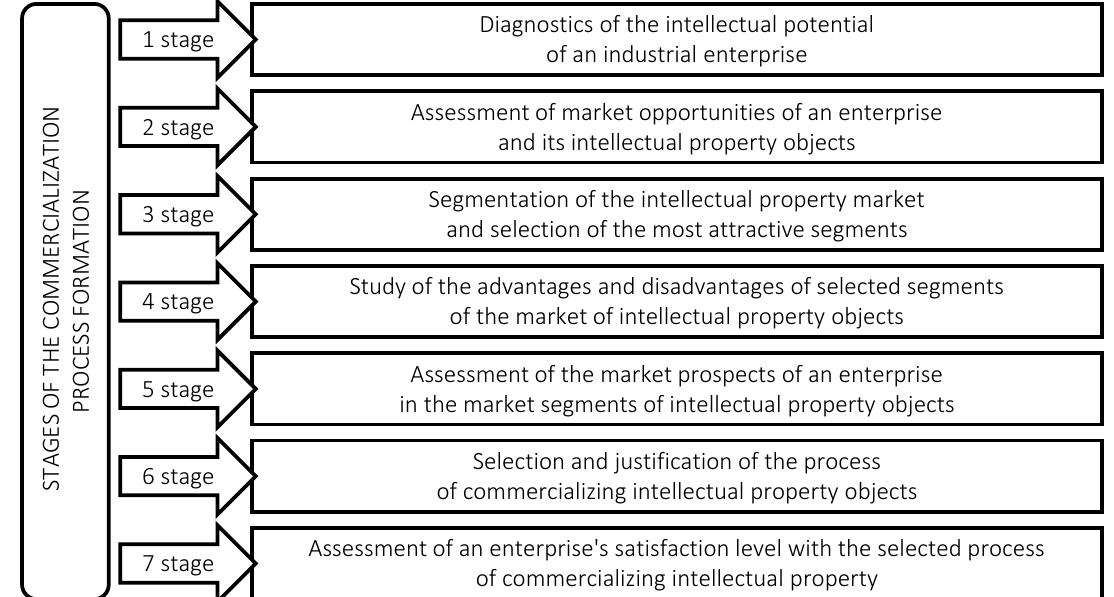
tion of the entire amount of profit from market sales at one enterprise, which is generally positive for the industrial enterprise when using risk in- vestments in the innovative process. A company-owner (developer) of an object of intellectual property